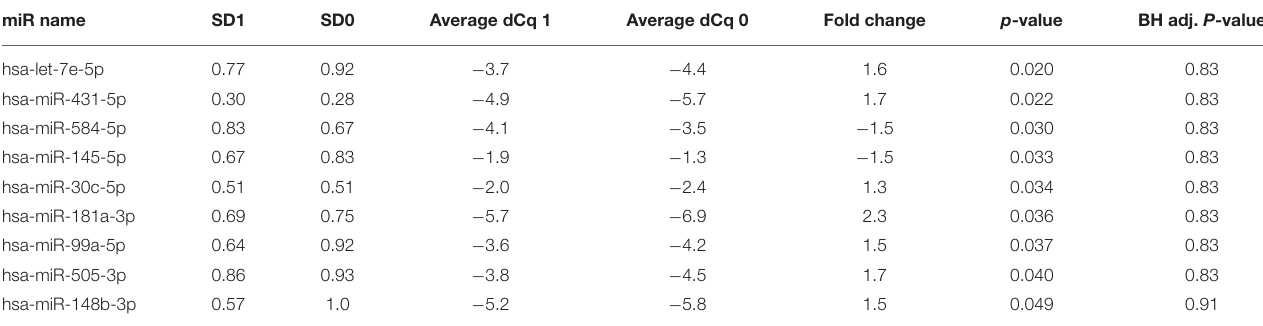
TABLE 2 | Top most differentially expressed miRNAs, showing the standard deviation (SD) across the groups, followed by average normalized Cq values for each group and fold change between the two